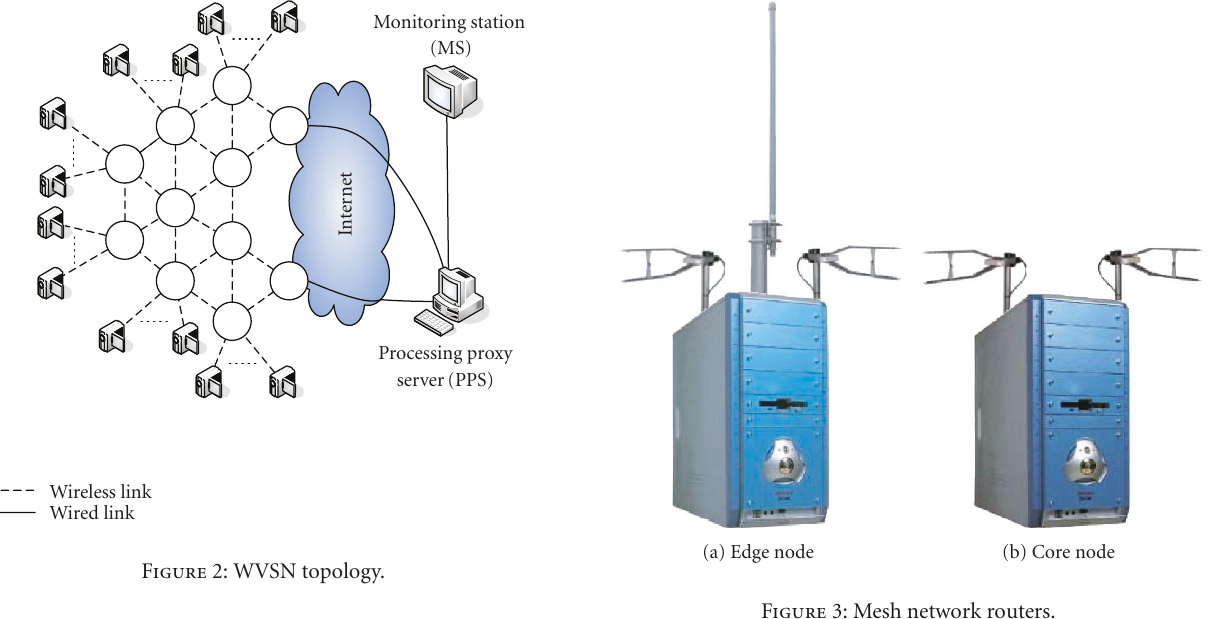
Figure 3: Mesh network